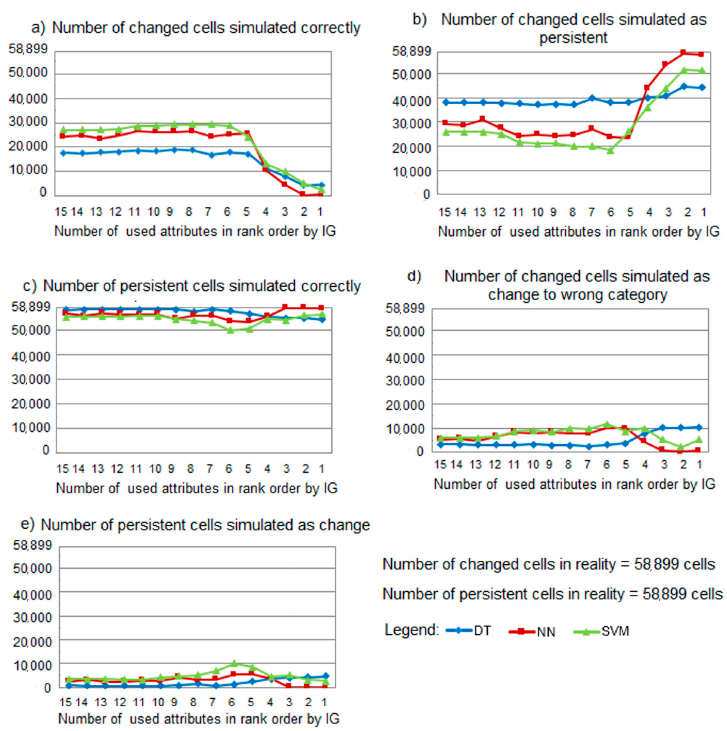
Figure 4. Effectiveness of the attribute selection when applied to building models based on three maps comparison methods: ( a ) Number of changed cells simulated correctly; ( b ) Number of changed cells simulated as persistent; ( c ) Number of persistent cells simulated correctly; ( d ) Number of changed cells simulated as change to wrong category; ( e ) Number of persistent cells simulated as change.